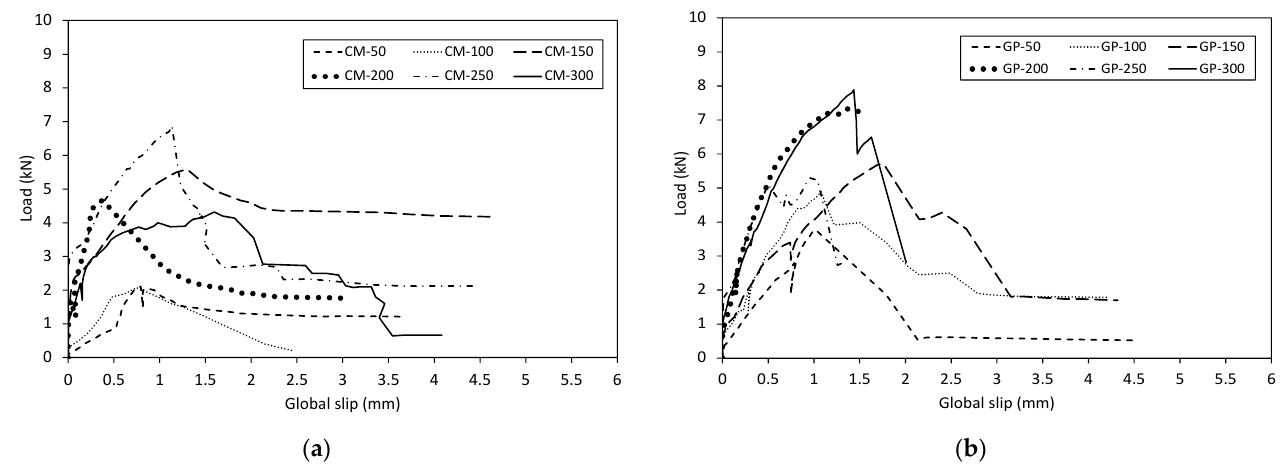
Figure 6. Load - global slip curves: ( a ) Cementitious-matrix specimens; ( b ) Geopolymeric-matrix specimens.